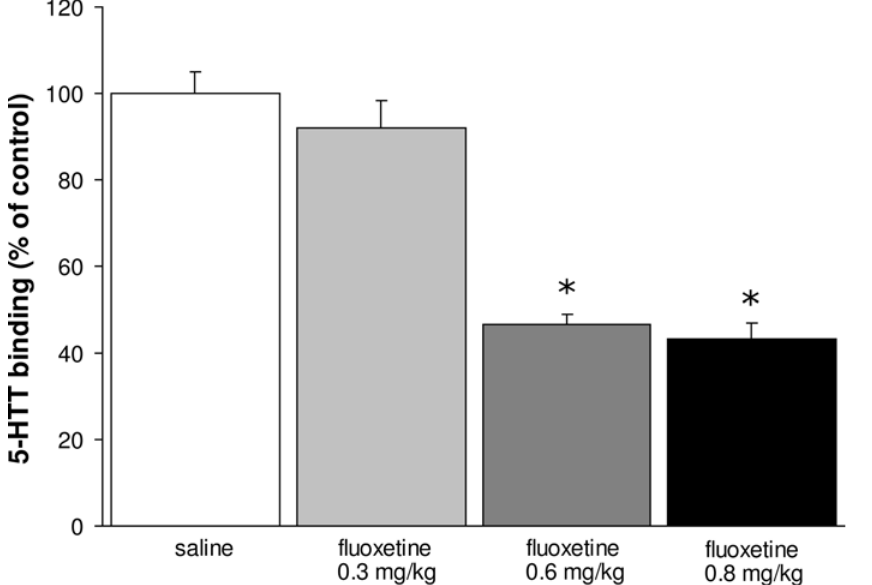
Figure 6. Binding of 5-HTT in the raphe nucleus at adulthood expressed as percentage of control 6 S.E.M. for groups treated with saline (white bars), 0.3 mg/kg/day fluoxetine (light gray bars), 0.6 mg/kg/day fluoxetine (dark gray bars) and 0.8 mg/kg/day fluoxetine (black bars). * p , 0.01.